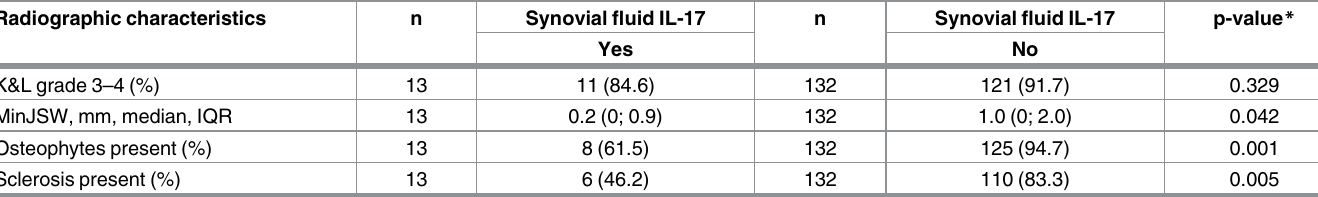
Table 3. Synovial fluid IL-17 levels in relation to radiographic characteristics.